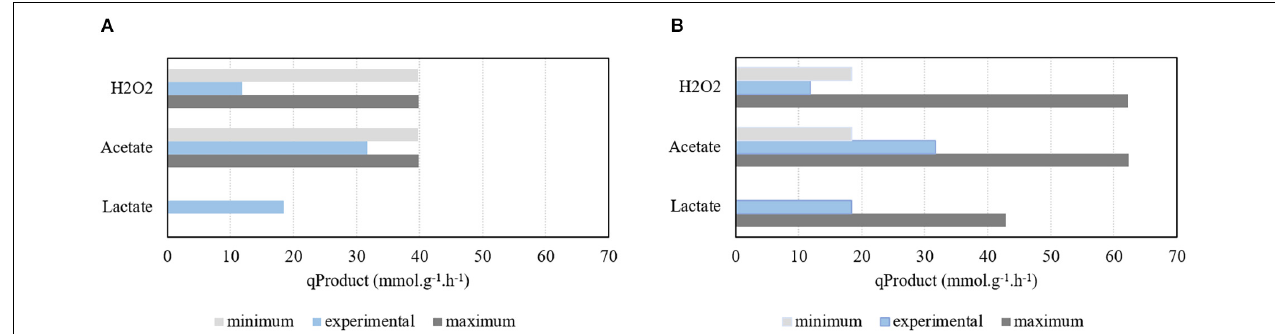
FIGURE 4 | Assessment of the model simulations performed under aerobic conditions for different glucose uptake rates (qGlucose) and comparison with experimental results. (A) Production of H 2 O 2 , acetate, and lactate using a qGlucose of 21.02 mmol g − 1 h − 1 . (B) Production of H 2 O 2 , acetate, and lactate using a qGlucose of 31.71 mmol g − 1 h − 1 . Growth rate was limited to 1.07 h − 1 .